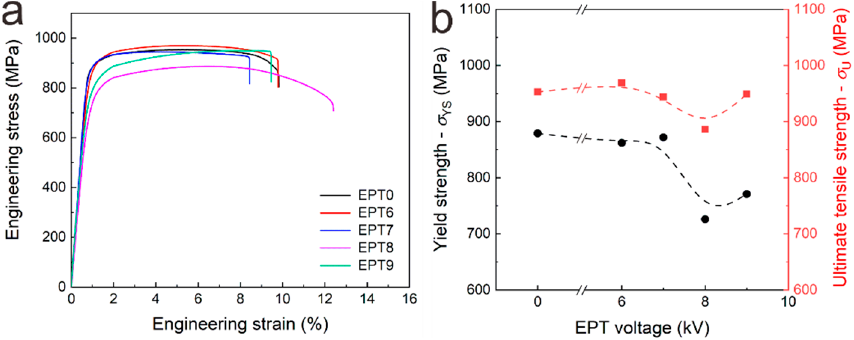
Figure 10. Tensile properties of the as-deposited and EPT samples. ( a ) Engineering stress–strain curves; ( b ) yield strength and ultimate tensile strength versus EPT voltages.